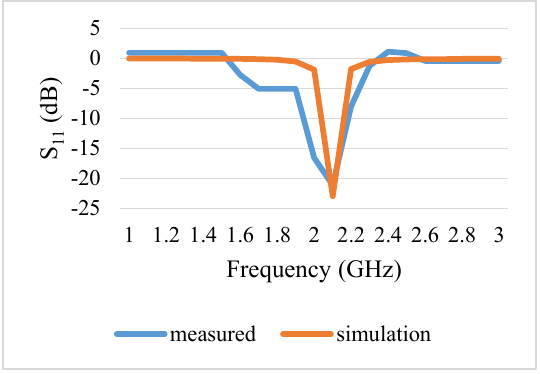
Fig.1.17 Rear view of fabricated antenna